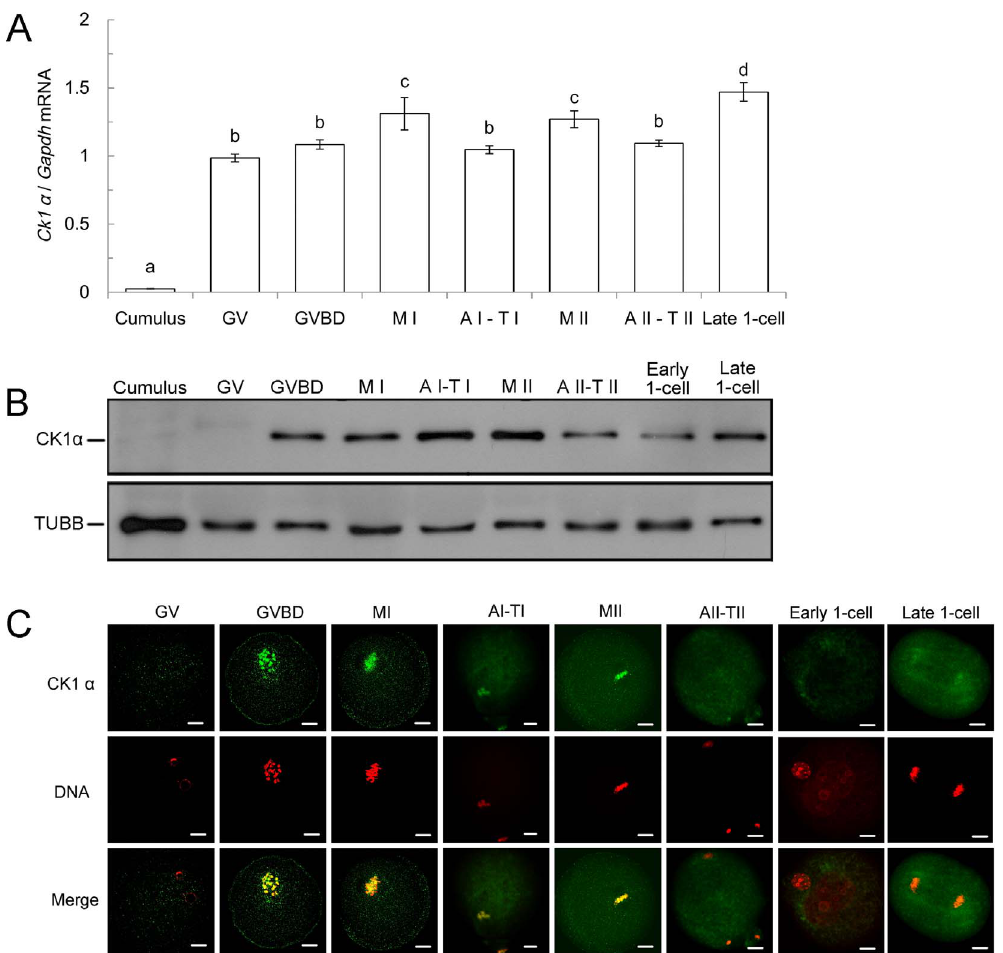
Figure 1. Expression and subcellular localization of CK1 a during mouse oocyte meiotic maturation and early embryonic development. (A) Levels of Ck1 a mRNA revealed by real time RT-PCR analysis. The transcript level of Ck1 a from cumulus cells, oocytes of GV, GVBD, MI, AI-TI, MII, AII-TII and embryos of late 1-cell stages (n=50 for each sample) were detected by real-time PCR. Graphical representation demonstrating pattern of Ck1 a mRNA levels between eight samples obtained from real-time PCR. Gapdh was used as internal control. Oocytes from GV stages were normalized to 1. Each bar represents mean 6 SEM (n=3). Different superscripts on the bar indicate statistical difference (p , 0.05). (B) Expression of CK1 a was detected by western blot. Cumulus cells from 5 mice and 200 oocytes for each sample were lysed in Laemmli buffer. TUBB was used as a loading control. The molecular mass of CK1 a and b -tubulin were about 39 kDa and 53 kDa, respectively. The results of one representative of three independent experiments are presented. (C) Subcellular localization of CK1 a during oocyte maturation and early embryo development. Oocytes at different stages were stained with antibody to detect CK1 a , and DNA was stained with PI. The slides were examined under a confocal microscope. Green: CK1 a ; Red: DNA; Merge: overlapping of green and red. Scale bar=10 m